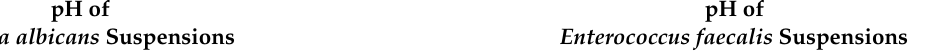
Table 3. pH values of C. albicans and E. faecalis suspensions incubated with BG1 – 3 at 5 and 15 mg mL −1 at 0, 24, and 48 h.